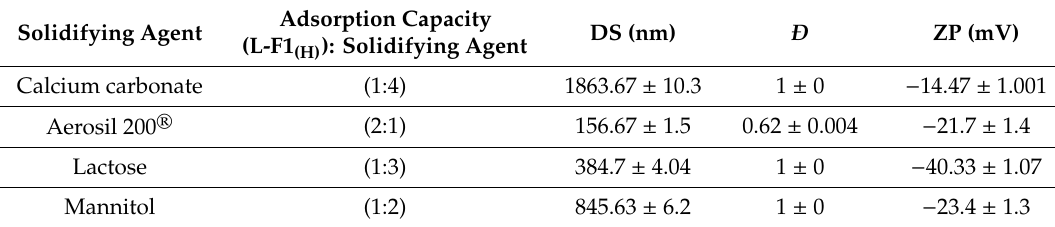
Table 6. Adsorption capacity and characterization of blank S-SEDDs (S-F1 (H) ) formulation. Mean ± SD, n =